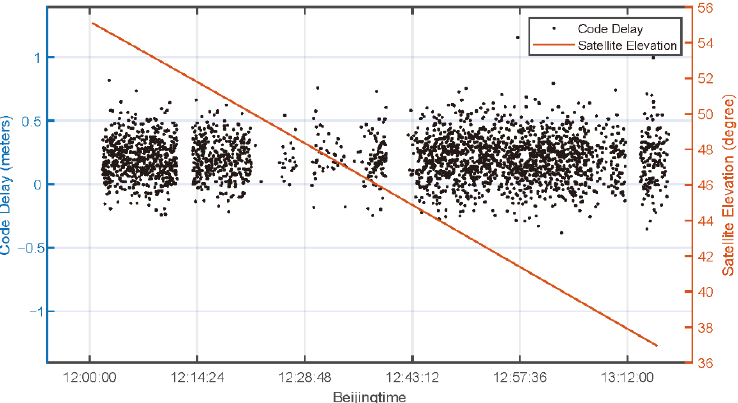
Figure 8. Time distribution of B2a PRN 39 satellite code signal path differences and satellite elevation.